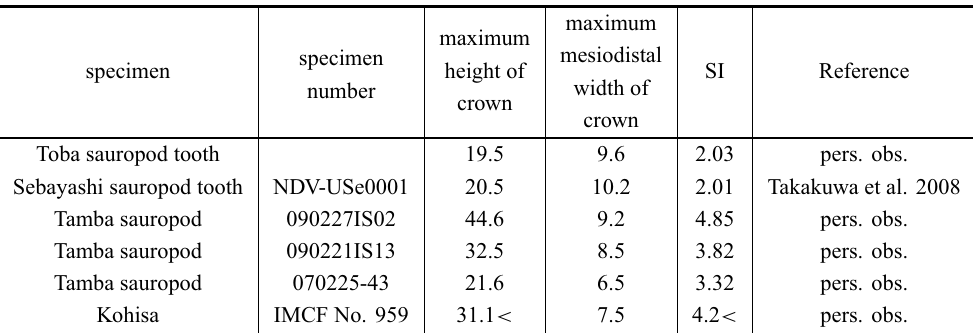
Measurements (in mm) and SI values of sauropod teeth from